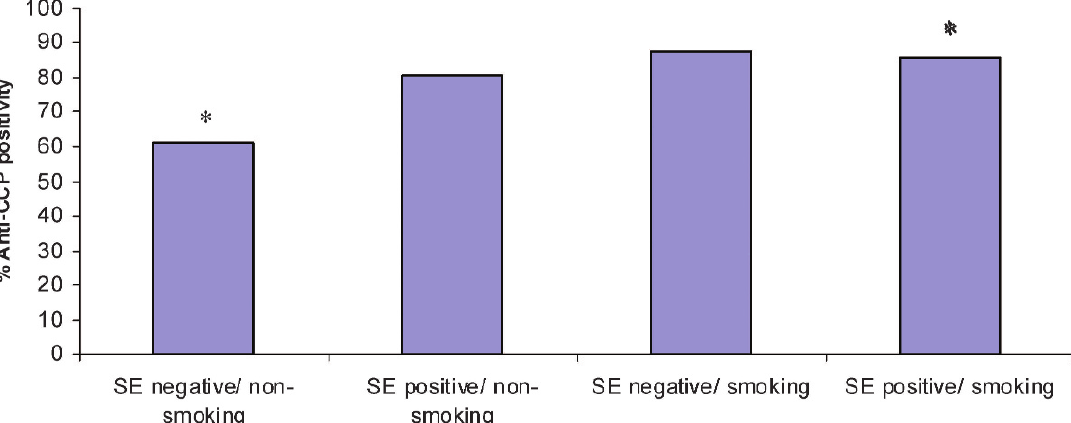
Figure 2 - Anti-CCP positivity according to SE status and smoking status. * statistically significant ( p =0.038); p = significance based on Pearson’s